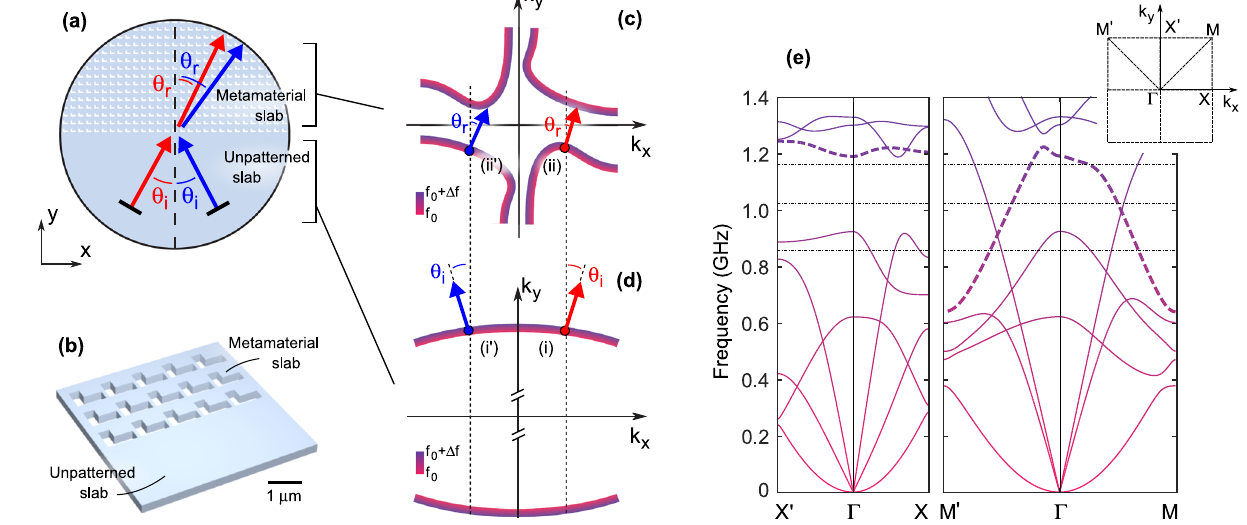
homogeneous slab. e Quantitative Bloch mode dispersion along high-symmetry paths in the fi rst Brillouin zone for the considered structure. The bold dashed curves represent the mode responsible for the refraction effects under analysis, speci fi cally analyzed at the frequencies identi fi ed by the horizontal dash-dotted lines (see also Figs. 3 and